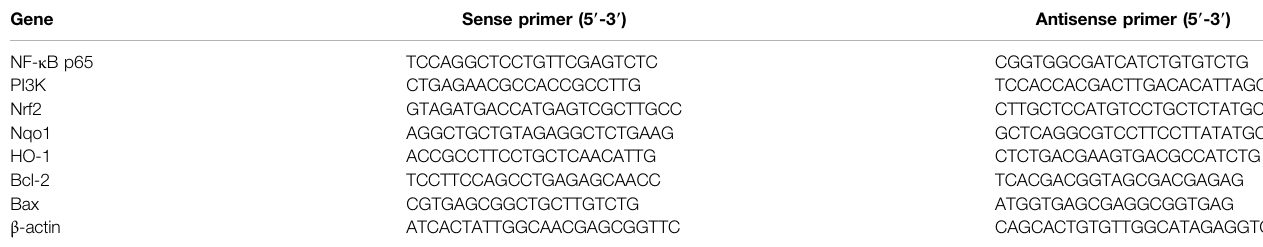
TABLE 2 | Primers sequences for RT-PCR.